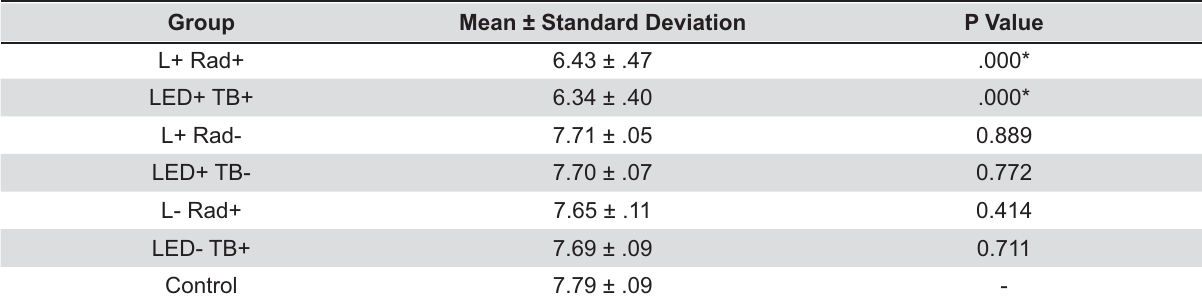
Table 1- Means±Standard deviation and P-value of the number of log10 obtained for the different Group